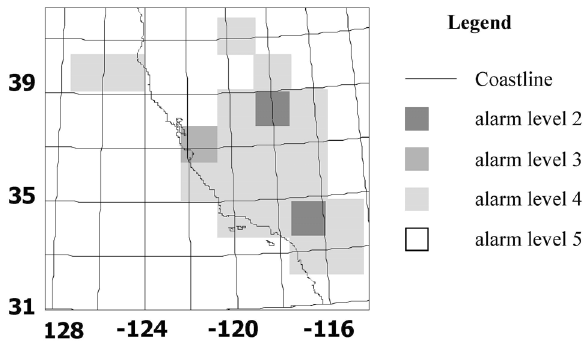
Figure 1. Mapped areas of five levels of half-year forward forecast- ing for California on March 8, 2006.